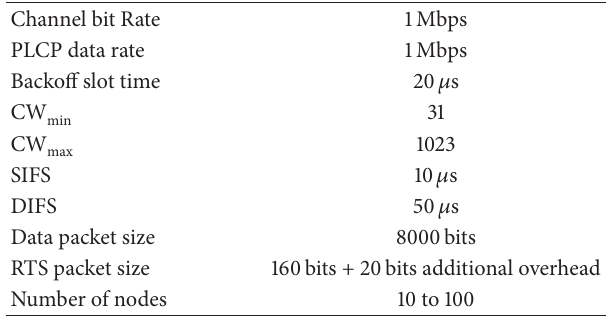
Table 3: Simulation